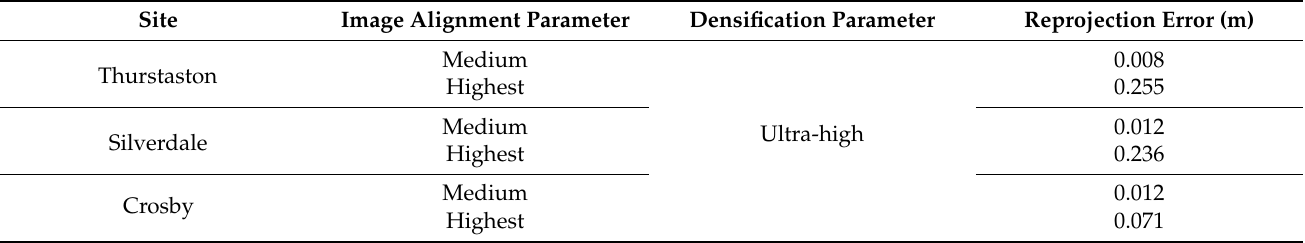
Table 2. Reprojection errors (m) for point clouds constructed under different Image Alignment parameters for Thurstaston, Silverdale and